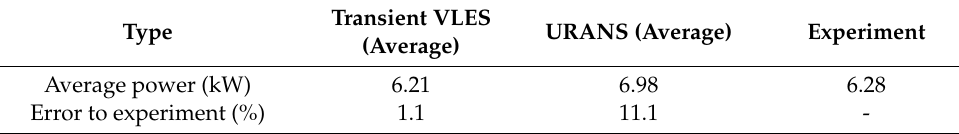
Table 4. Comparison of CFD power values with experimental data (wind speed = 7 m/s).